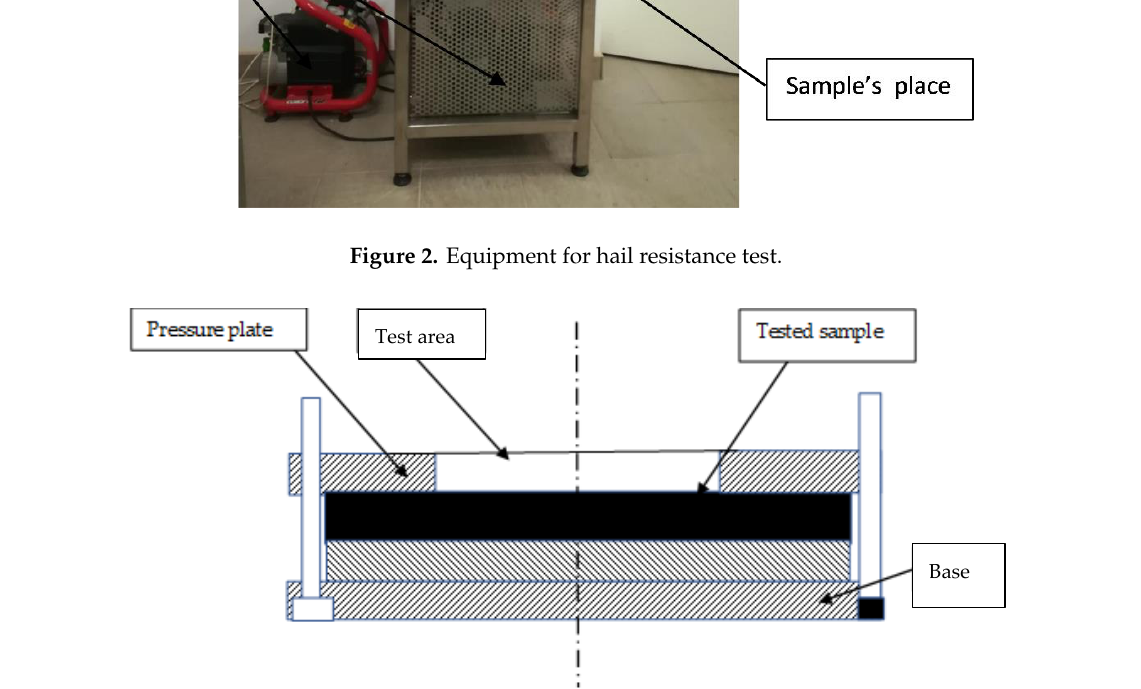
Figure 2. Equipment for hail resistance test .